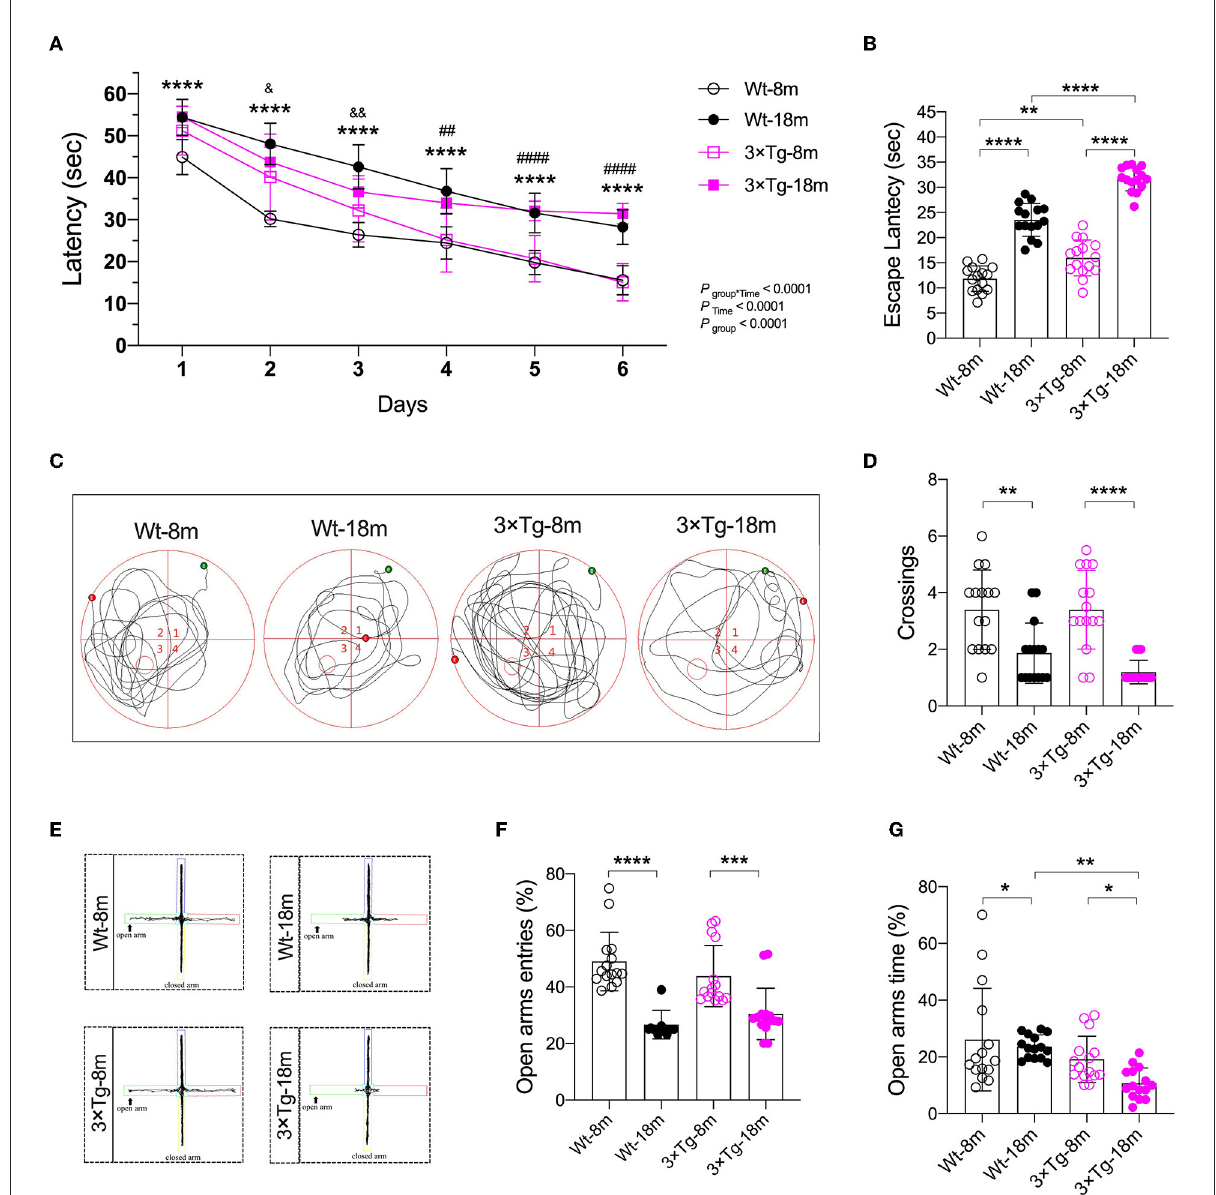
FIGURE2 Cognitive impairment during aging in the wild-type and 3 × Tg AD mice. (A) In the Morris water maze (MWM) test, a learning curve was made after consecutive training. Escape latencies were analyzed using a two-way ANOVA using Tukey’s post hoc test, n = 15, F (15,280) = 7.493. **** P < 0.0001, Wt-18m vs. Wt-8m; ## P < 0.05, #### P < 0.0001, 3 × Tg-18m vs. 3 × Tg-8m; & P < 0.05, && P < 0.01, 3 × Tg-18m vs Wt-18m. (B–D) Escape latency [F (3, 56) = 129.2, P < 0.001], representative swimming route, and number of crossings [F (3, 56) = 14.25, P < 0.001] in the target quadrant were made in the probe test of the MWM test. Data were analyzed with one-way ANOVA using Tukey’s post hoc test, n = 15. (E–G) In the elevated plus maze (EPM) test, representative moving route, the number of entries F (3, 56) = 20.43, ( P < 0.0001), and stay duration [F (3, 56) = 6.277, P = 0.0010] in the open arm were recorded. Wt, wild-type mice; 3 × Tg, triple transgenic mice. Data are presented as mean ± SEM, n = 15, * P < 0.05, ** P < 0.01, *** P < 0.001, **** P <